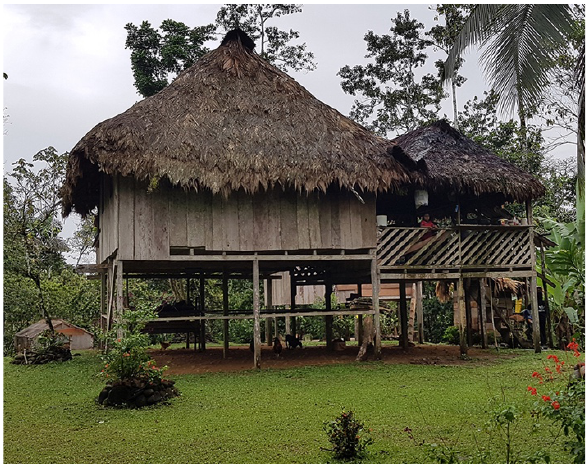
Figure 9. Tambo house in Sieikin, Naso